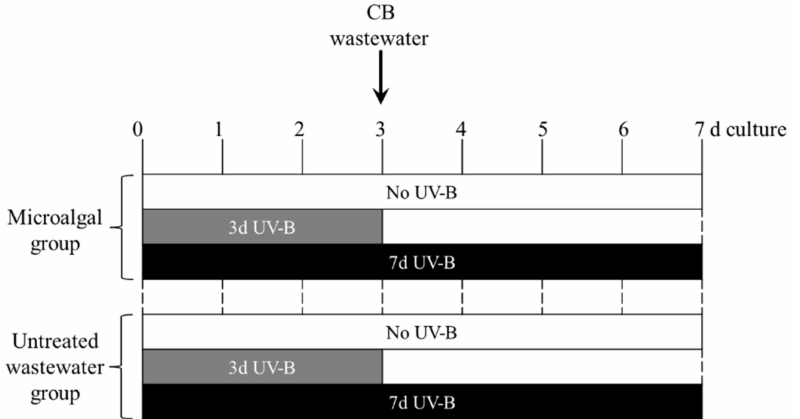
Figure 5. Experimental design of the study. All treatments were carried out under PAR. UV-B irradiation was applied either before (3 d UV-B) or in parallel to (7 d UV-B) a 4-day wastewater treatment. The control microalgal group only received PAR (No UV-B). Another parallel untreated wastewater group (no microalgae) was included, and it was exposed to each UV-B treatment (No UVB, 3 d UV-B and 7 d UV-B). Sampling was performed in 7-day cultures. See Sections 4.2 and 4.3 for details of treatment conditions. CB; cigarette